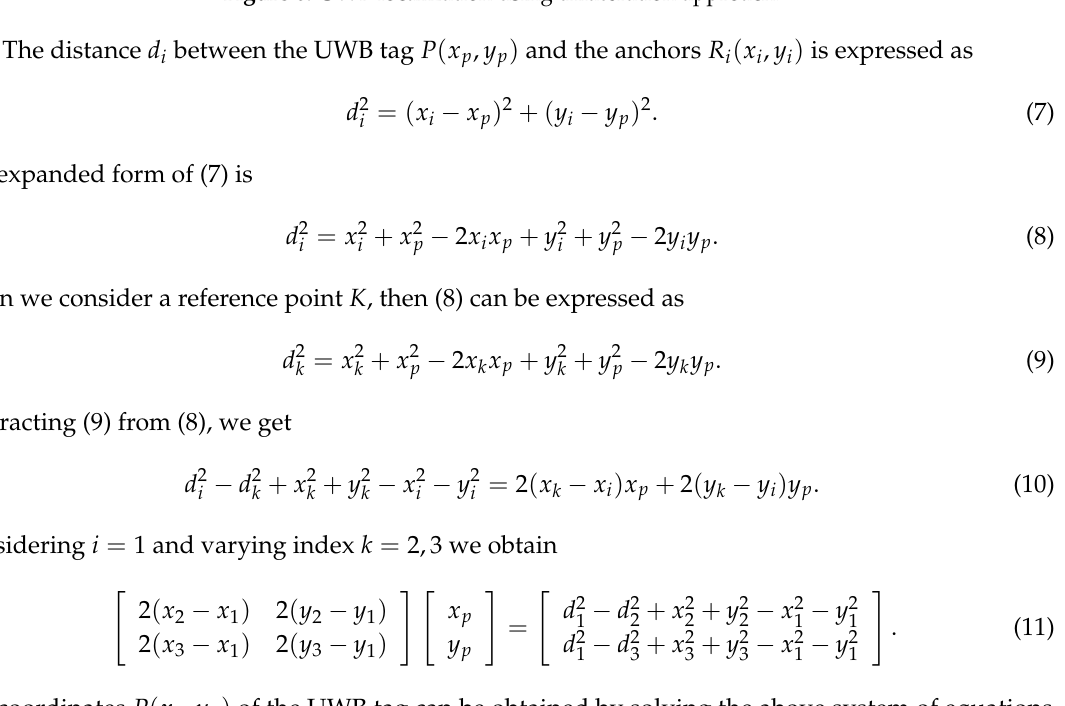
Figure 6. UWB localization using trilateration